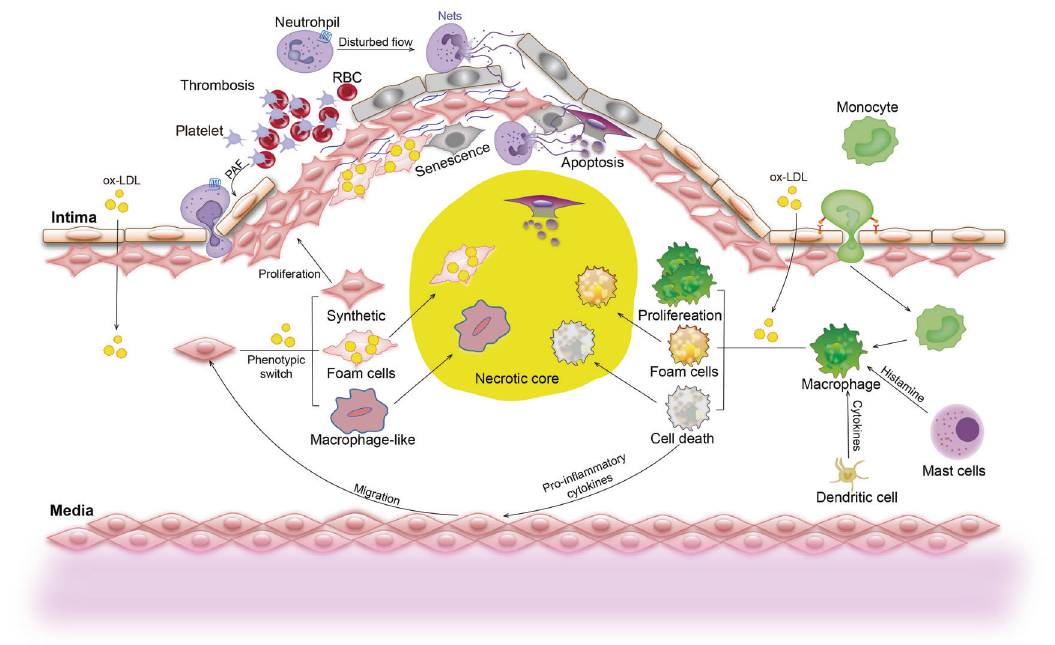
Fig. 2 Overview of in fl ammatory responses in atherosclerotic development. At the early stages, activated platelets mediate fi rm adhesion between platelets, leukocytes, and the vascular endothelium by secreting platelet-activating factor (PAF). In progressing plaques, VSMCs migrate from the medial to the subendothelial space where they undergo proliferation and developing fi brous cap. OxLDL induces phenotype switching of VSMCs to synthetic, macrophage-like VSMCs and the formation of foam cells. Excessive deposition of lipids triggers VSMC apoptosis and senescence, leading to necrosis. At predilection sites with the disturbed fl ow, neutrophil-released neutrophil extracellular traps (NETs) induce desquamation of endothelial cells and lead to rapid occlusion of the affected vessels. Monocyte-derived macrophages ingest oxLDL and release pro-in fl ammatory cytokines. Excessive deposition of lipids, as well as cytokines and histamine released from dendritic cells and mast cells, trigger the proliferation, polarization of macrophages, or even cell